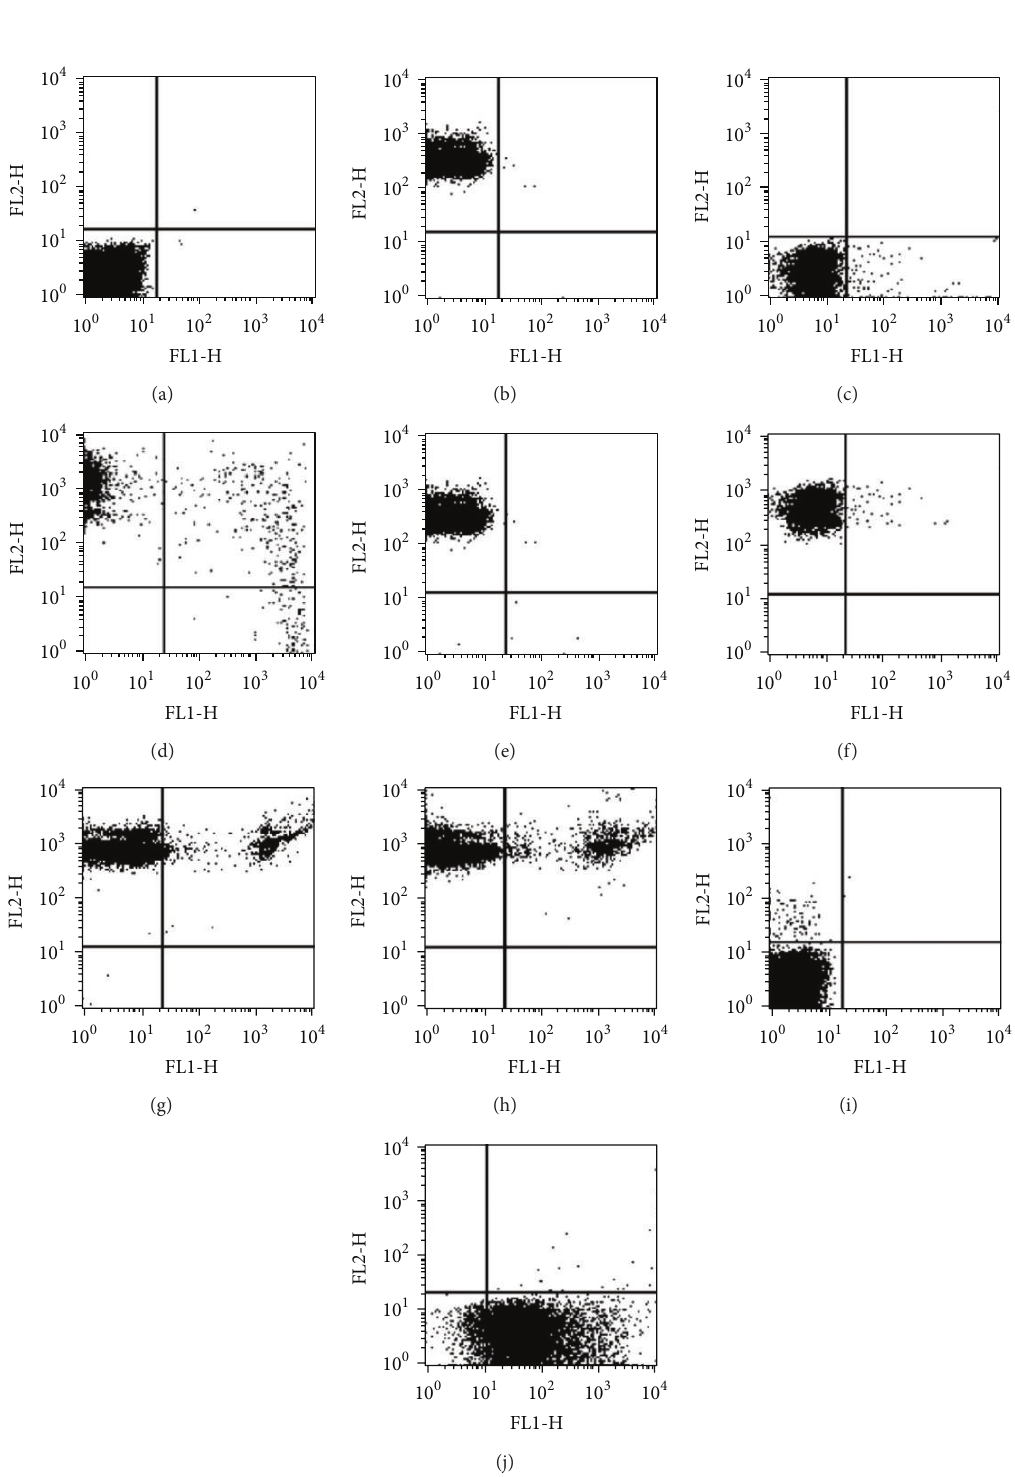
Figure 2: Representative two-channel (FL-1/FL-2) dot-plots, examining various levels of parasitemia. Cultures of P. falciparum were stained with SYBR Green I and CD235A (a–h), and Propidium Iodide and Anti-H (i-j). Over 5,000 events were acquired for each dotplot. (a) Normal unstained RBCs were plotted on the lower left corner. (b) Anti-CD235A PE stained RBCs were plotted between 10 1 and 10 3 on the red axis with small diagonal stretch from the upper left corner (FL2). (c) P. falciparum infected RBC populations were plotted parallel to the noninfected RBCbetween10 1 and10 4 onthegreenaxis(FL1).(d) P. falciparum infectedRBCpopulationscontrolsstainedwithSYBRGreenIandCD235A. Suspected external merozoites from RBCs were localized on the right lower quadrant. Synchronized cultures of P. falciparum with parasitemia were used. (e) 0.01%, (f) 0.5%, (g) 10.0%, and (h)